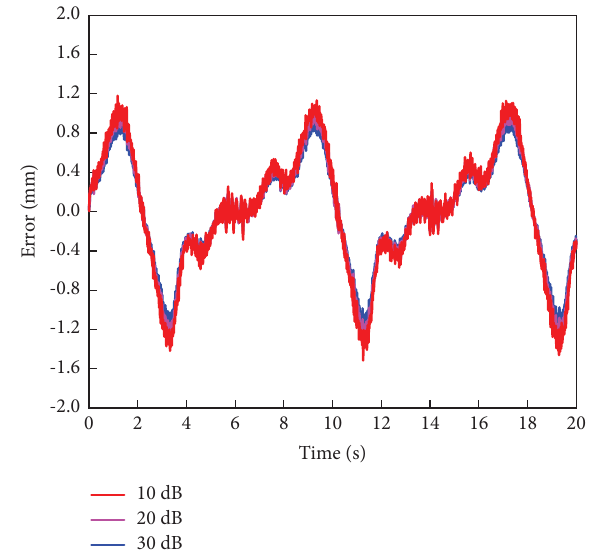
Figure 12: Comparative tracking errors of multifrequency sinusoidal signal under diferent